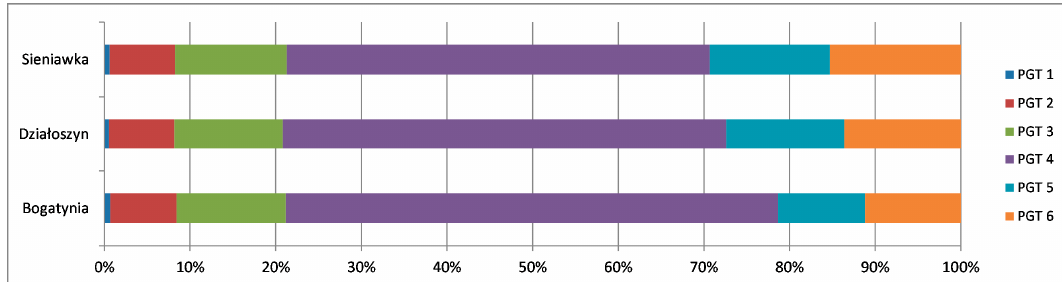
Figure 13. Share of the Pasquill atmospheric stability classes determined by the WRF/CALMET model in selected towns in 2018 (source: own study).